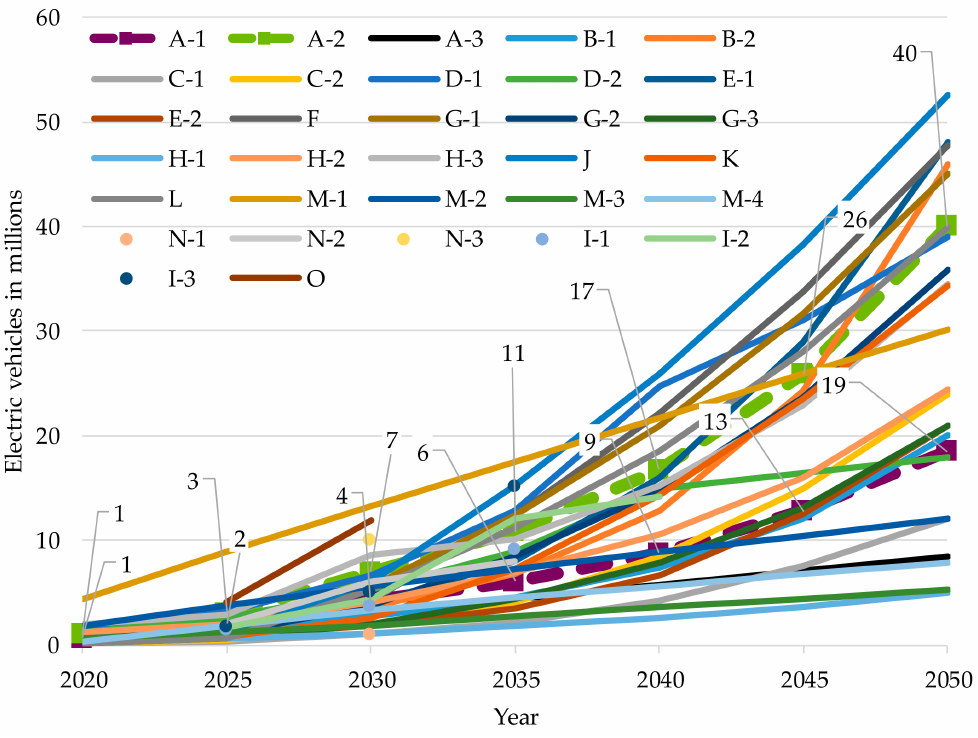
Figure 1. Ramp-up trajectories for EV development scenarios in Germany based on